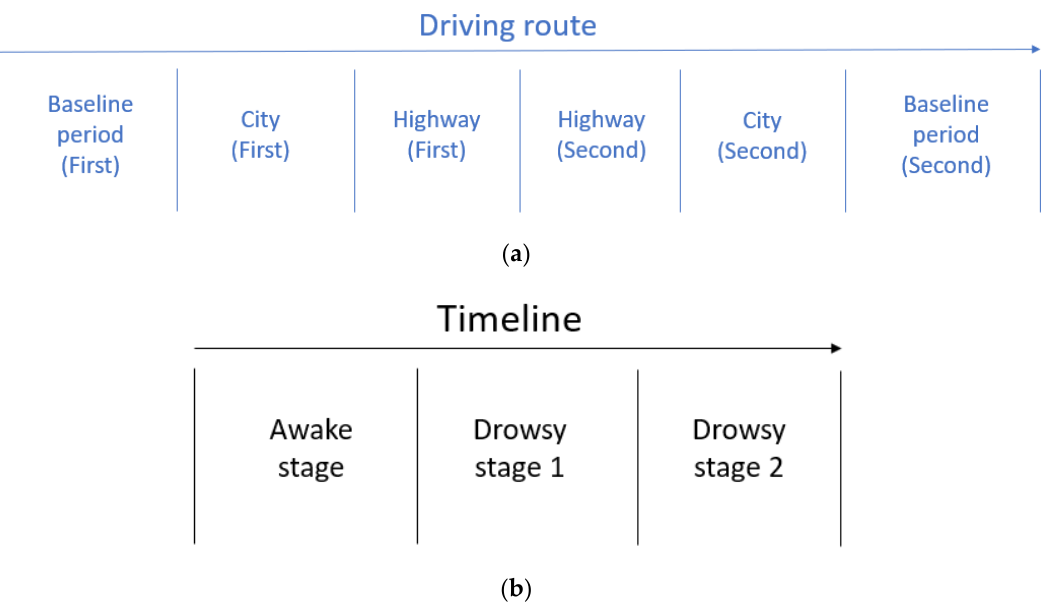
Figure 1. ( a ) Scenario setting in the Stress Recognition in Automobile Drivers Database and ( b ) the scenario setting in the cyclic alternating pattern (CAP) Sleep Database.